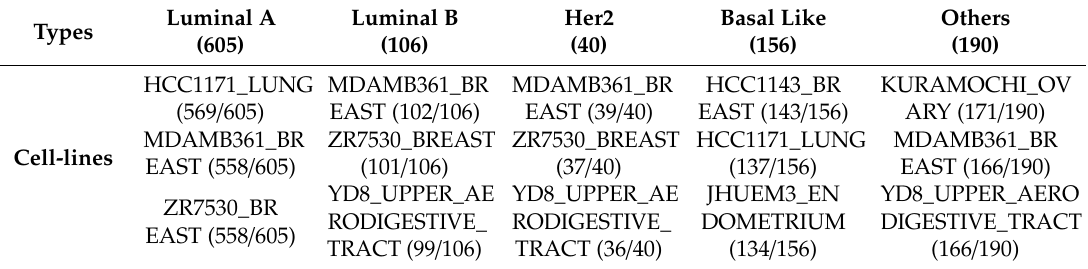
Table 4. The most frequent three cancer cell lines for 1097 patients in five subtype breast cancer patients.